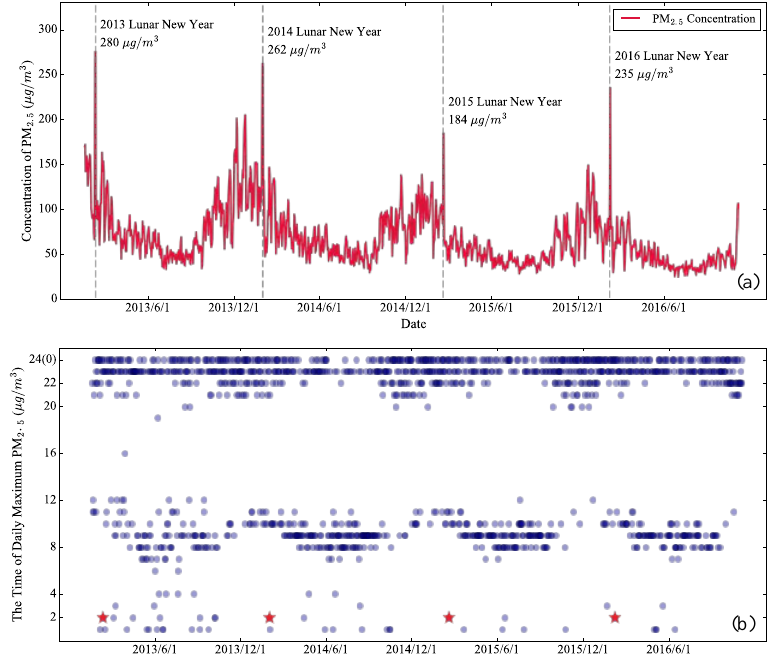
Figure 4. ( a ) Station-based daily maximum PM 2.5 , and ( b ) its time distribution in mainland China from 18 January 2013, to 6 November 2016. Each New Year’s Day is marked with a dashed gray line (in ( a )) or a red pentagram (in ( b )), and the corresponding PM 2.5 concentrations are given in ( a ). It should be noted that these are the highest values of the corresponding years, and these peaks all appeared at 2 a.m. on Lunar New Year’s Day. So, we recorded the time when the national average PM 2.5 reached the maximum each day to observe its distribution. According to Figure 4b, daily PM 2.5